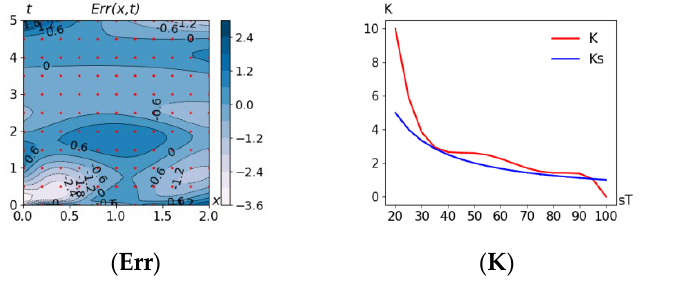
Figure 8. SvF solution of Problem 5.5: ( Err ) Err(x,t) = T(x,t)-Ts(x,t) ; ( K ) the thermal conductivity co- efficient.